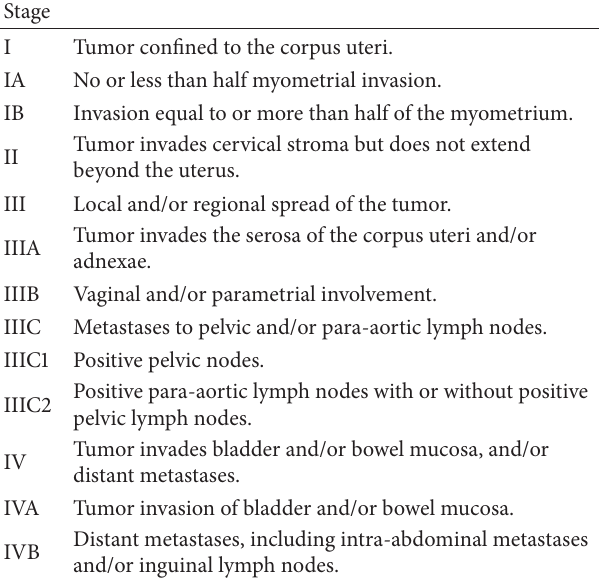
Table 3: 2009 FIGO endometrial cancer